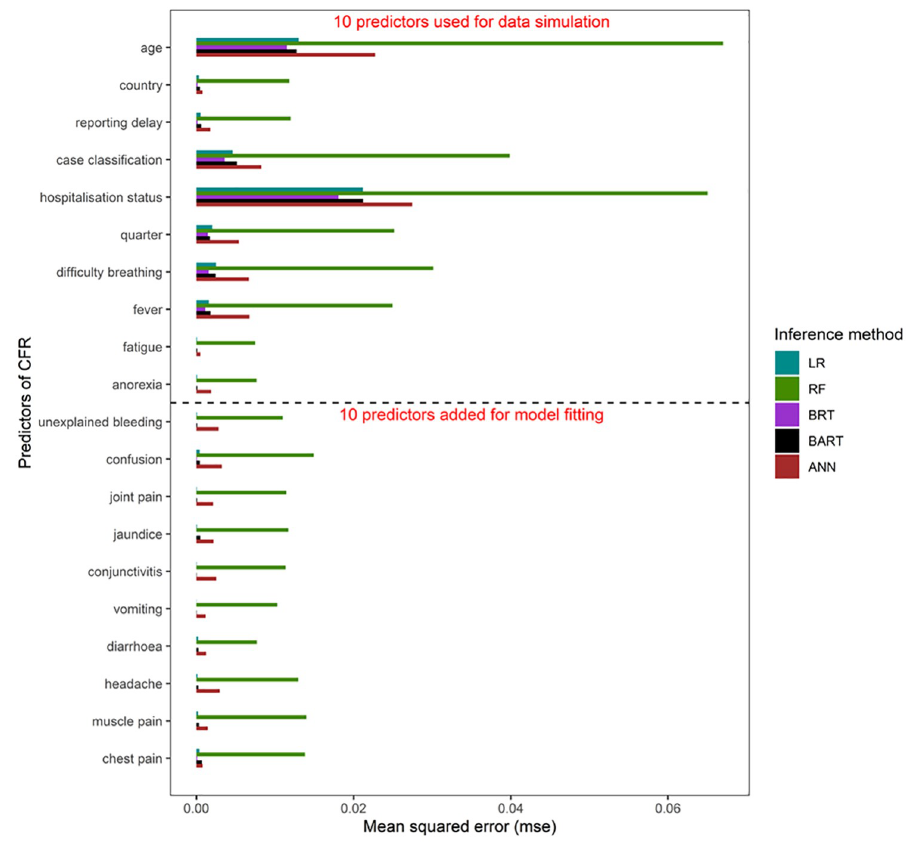
Fig 1. Inferential performances (mean squared error [mse]) for all 20 predictors of Case Fatality Ratio (CFR) estimated for each method (i.e., LR, RF, BRT, BART, ANN). The dotted horizontal line separates the ten predictors used in the simulation process from the ten predictors added for model